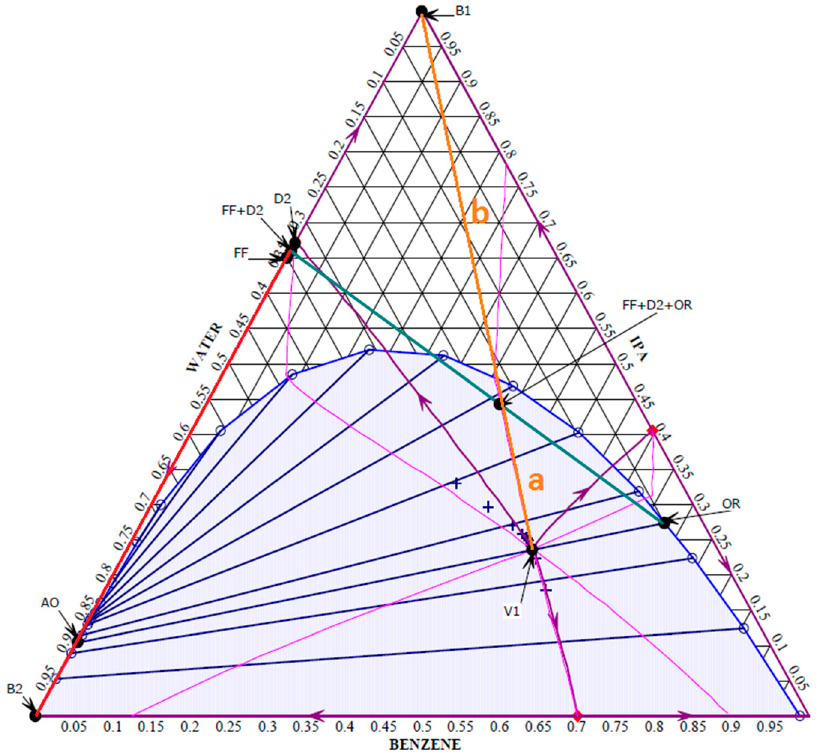
Figure 5. Ternary map at 1 atm for the system 2-propanol (IPA) + water (WATER) + benzene (BENZENE), showing the points corresponding to the streams involved in the process shown in Figure 1, the material balance line for the HAD column (in orange), segments a and b for the calculation of the V1 flowrate (Equation (1)), and the material balance line for the recovery column (in red).